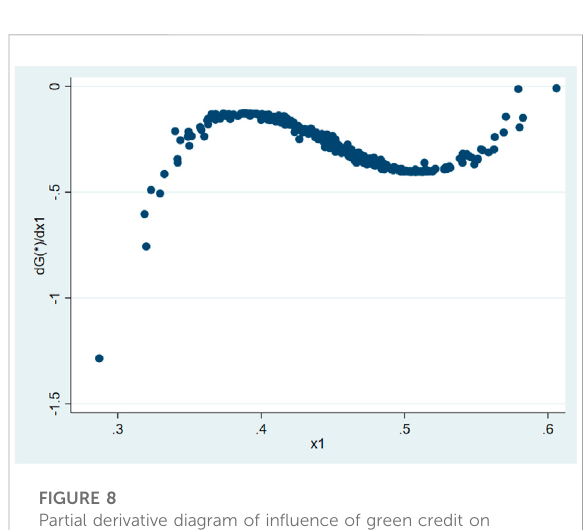
FIGURE 8 Partial derivative diagram of in fl uence of green credit on carbon